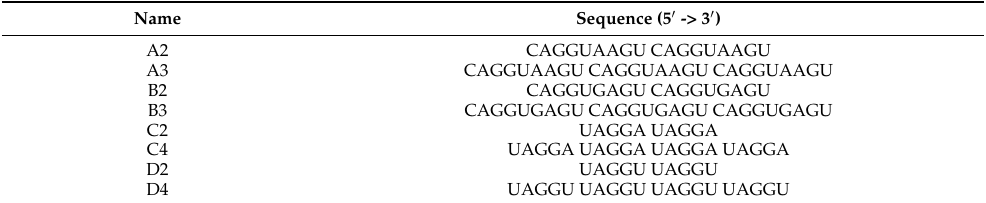
Figure 1. Investigations of oligonucleotides affinity to hnRNP A1. ( A ) Representative EMSA screening of oligonucleotides interacting with hnRNP A1. The oligonucleotide sequences can be found in Supplementary Material Table S1. ( B ) Representative EMSA gel for Kd determination. The amount of formed complex increases with the concentration of protein. The Kd value was calculated based on the band intensities of complex and free oligonucleotide. The number below the bottom bands presents the percentage of free oligonucleotide. The gel represents EMSA assay with C4 oligonucleotide. ( C ) The binding affinity (Kd) of oligonucleotides containing repetitions of basic sequences. The error bars present the upper and lower limits of 95% confidence intervals. Table 1. Oligonucleotides that consist of basic sequence repetitions, which were found to be preferen- tially recognized by hnRNP A1